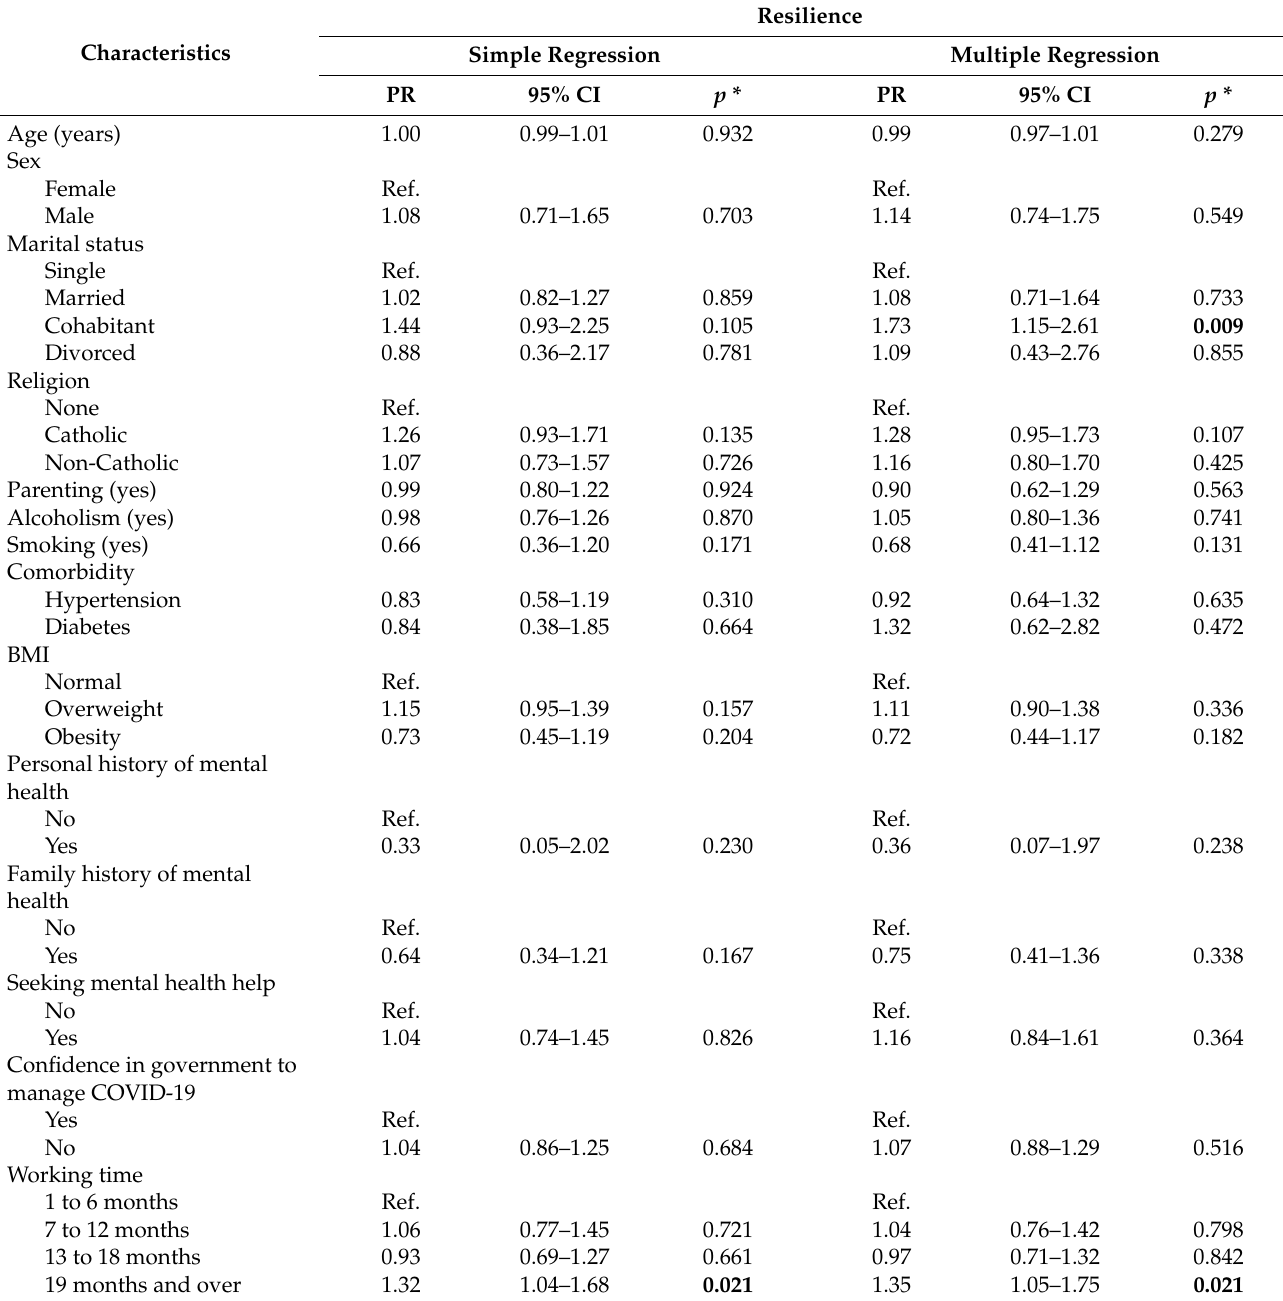
Table 3. Factors associated with resilience in simple and multiple regression